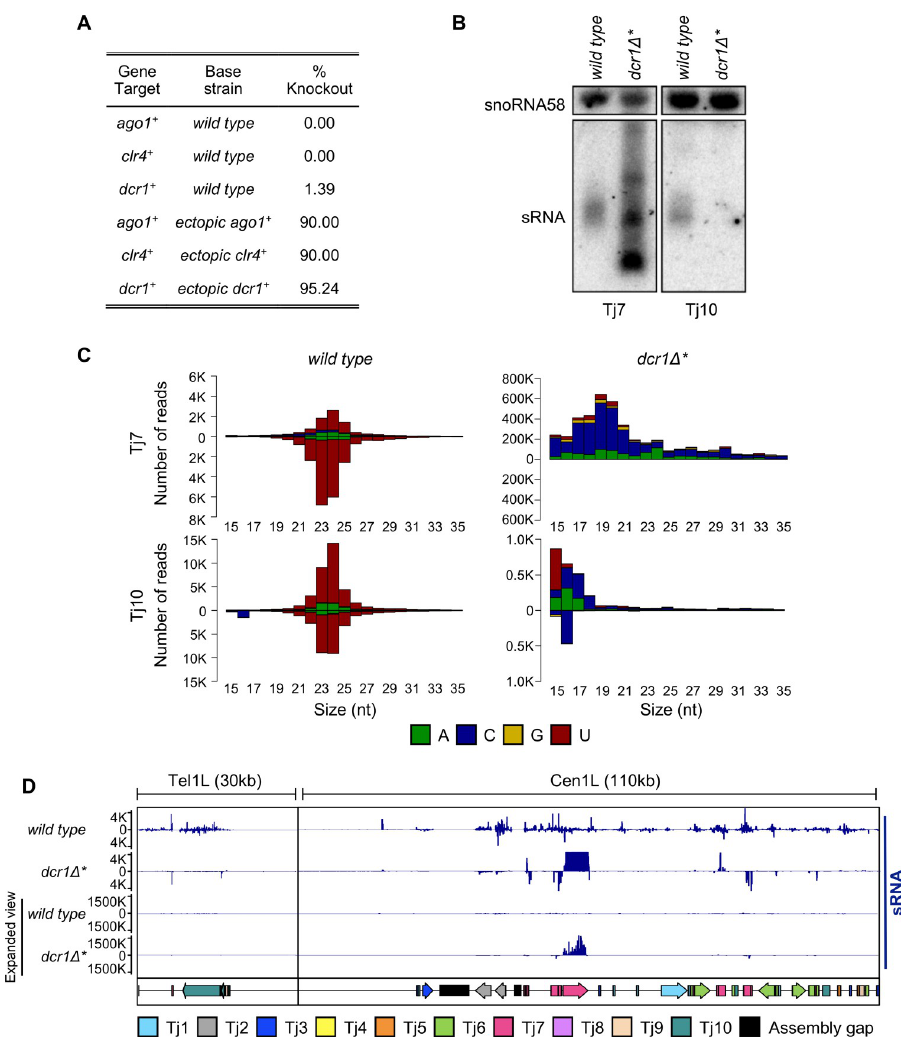
Fig 1. A functional RNAi pathway is required for viability in S . japonicus . (A) Knockout recovery rates of core RNAi and heterochromatin factors in wild-type and ectopic expression backgrounds. (B) Northern blot analysis of small RNA species isolated from wild-type and dcr1 Δ � strains, probed with 32 P end-labelled oligonucleotides, antisense to the indicated retrotransposon or snoRNA58 loading control. (C) Size profile, strand bias and 5’ nucleotide preference of small RNA species that map to indicated retrotransposons, isolated from wild-type and dcr1 Δ � strains. RNAs derived from the sense strand are plotted above the axis, whilst RNAs derived from the antisense strand are plotted below. (D) Genome view of mapped small RNA species at two retrotransposon-rich loci, in wild-type and dcr1 Δ � backgrounds. Note differing scale in the expanded view tracks. The positions of individual transposable elements are indicated by coloured arrows below the data